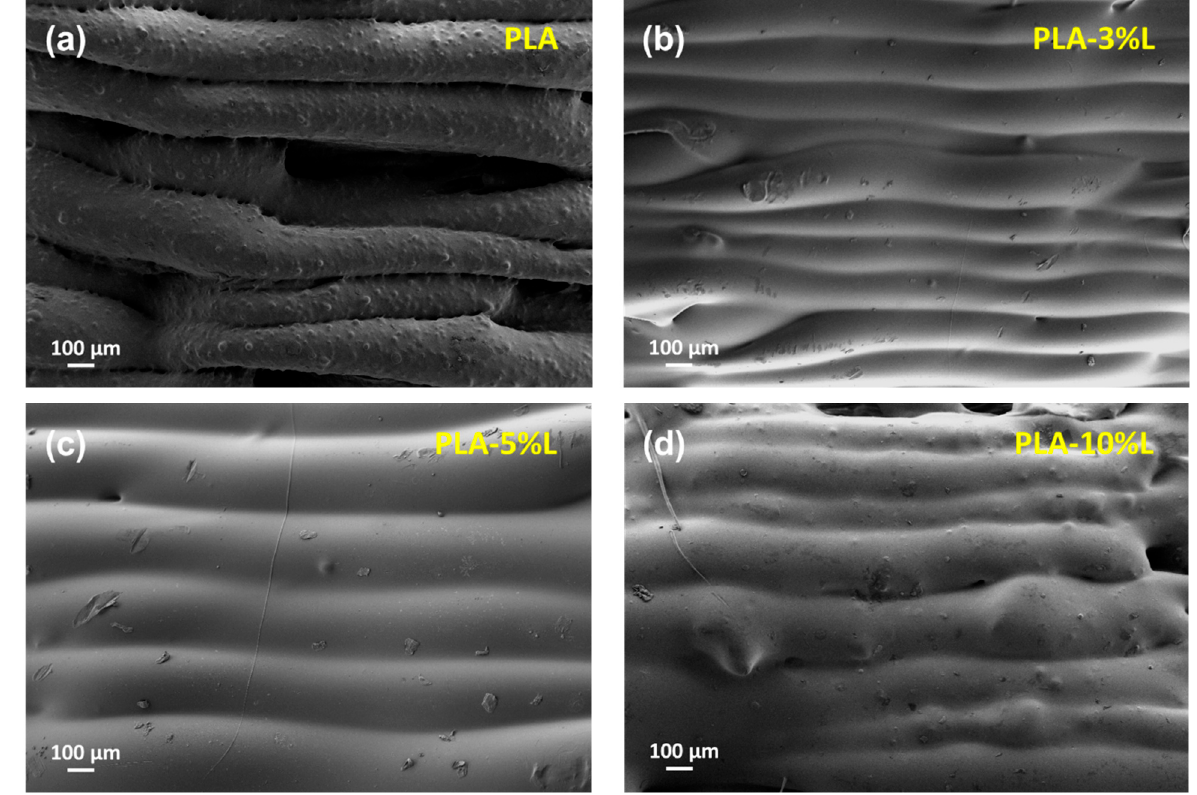
Figure 5. Cross-sectional area micrograph of 3D printed ( a ) neat PLA ( b ) PLA-3%L ( c ) PLA-5%L and ( d ) PLA-10%L. Table 3. Previous research on using lignin as a biofiller in FDM filament production.